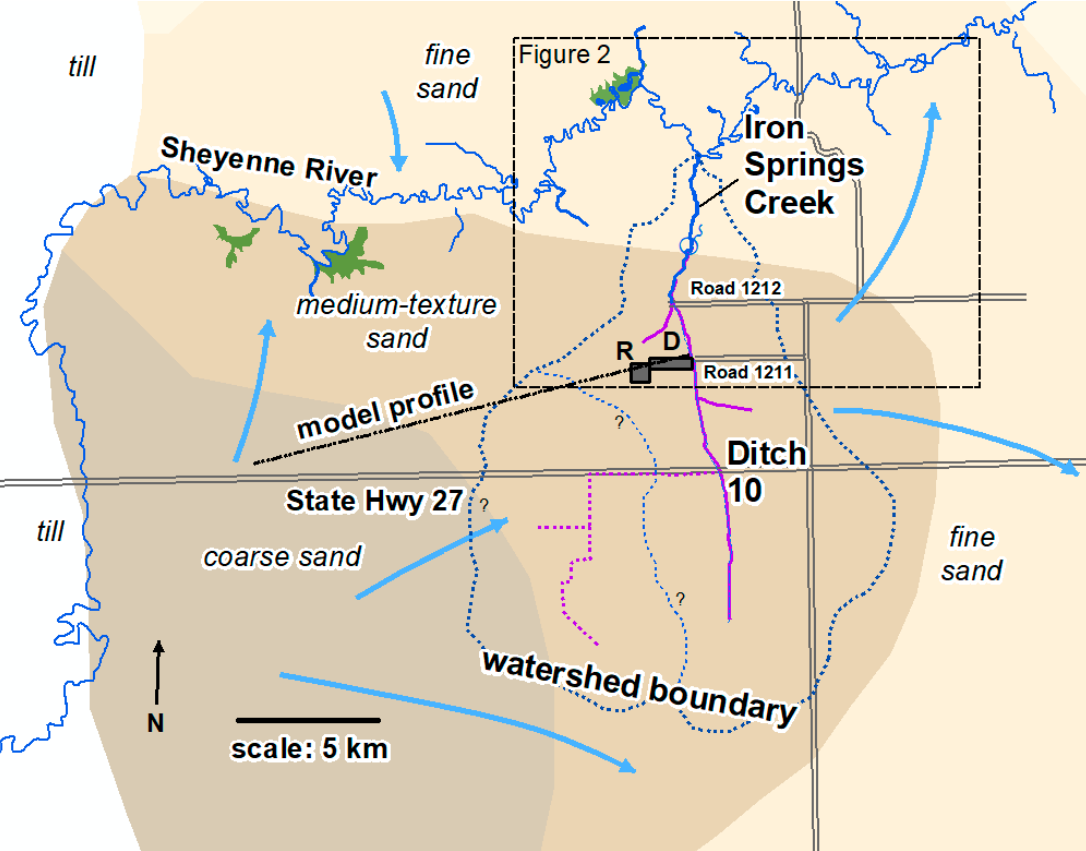
Figure 1. Map of the Iron Springs Creek - Drain 10 channel and watershed within North Dakota’s Sheyenne grassland (insert). The blue arrows show the general direction of groundwater flow in the unconfined aquifer. The tributaries to the Sheyenne River and green areas zone indicate major springs and seeps, with the large spring symbol showing the location of former Iron Springs. The gray rectangles west of Road 1211 delineate the monitoring and modeling quadrants for this study (R and D are the reference and disturbed blocks, respectively, as noted in the text).